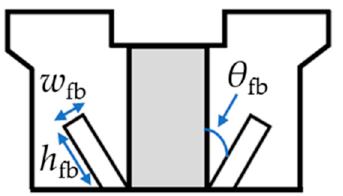
Figure 3. Design variables of the proposed flux barriers.